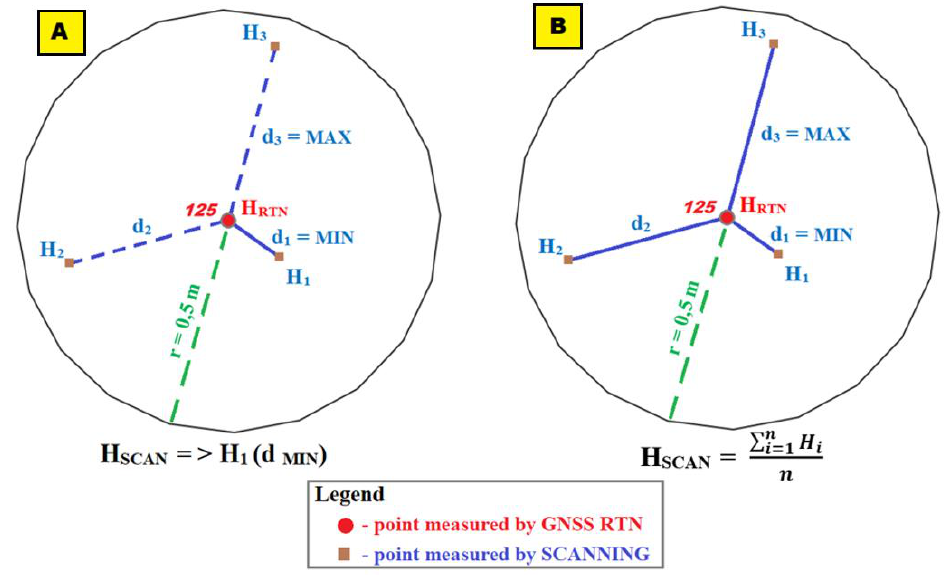
Figure 5. Comparison of “cloud to cloud” heights .